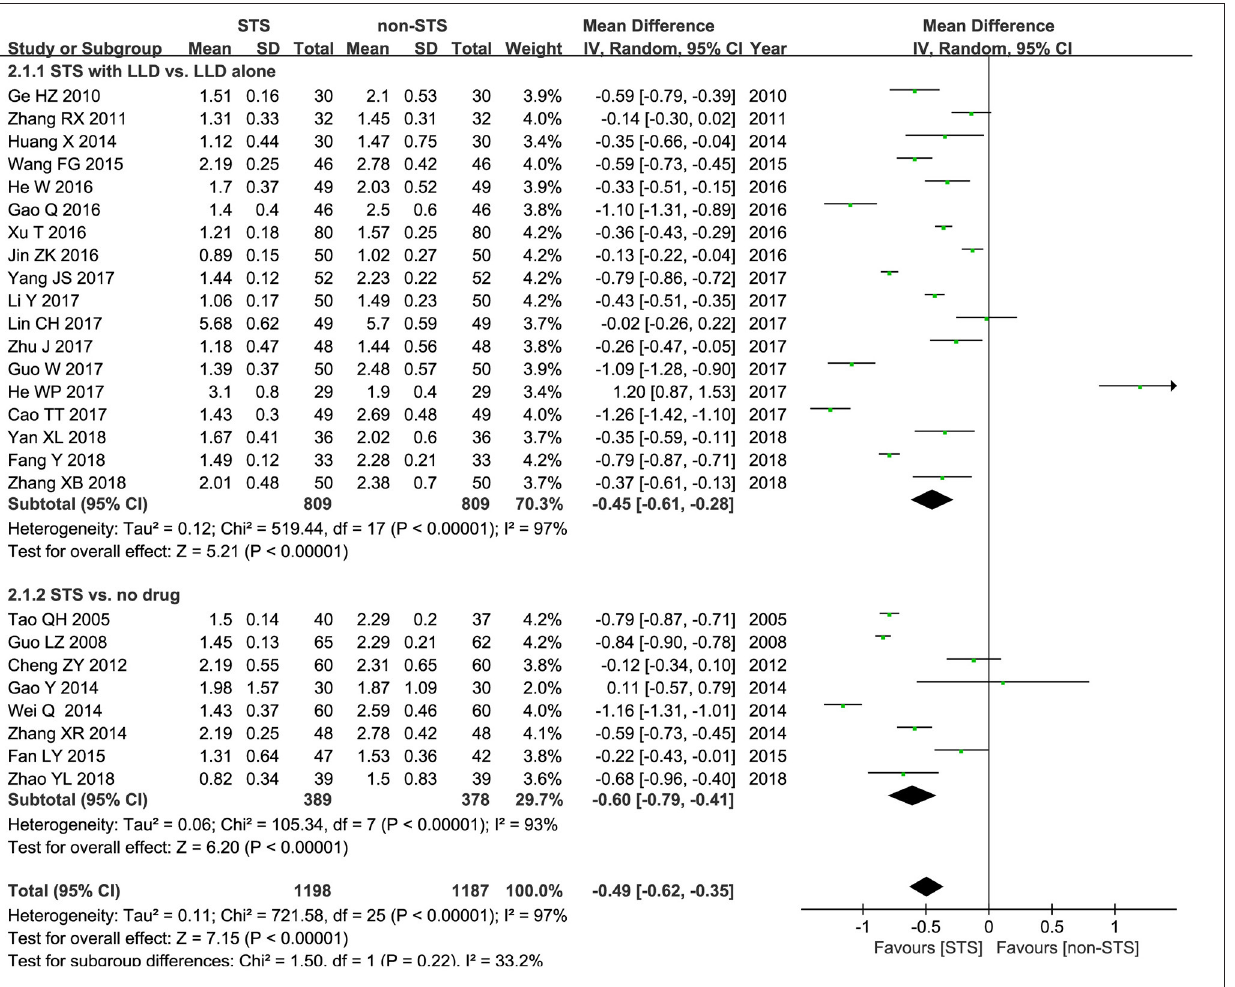
FIGURE 4 | Forest plot of comparison: STS vs. non-STS in TG.